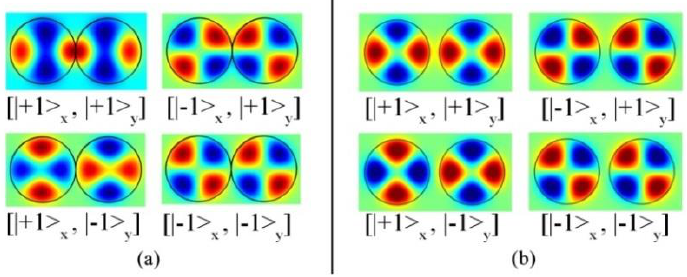
Figure 2. The electric field z component distribution of the collective mode TM 2,1 . ( a ) g = 0 nm and ( b ) g = 15 nm.